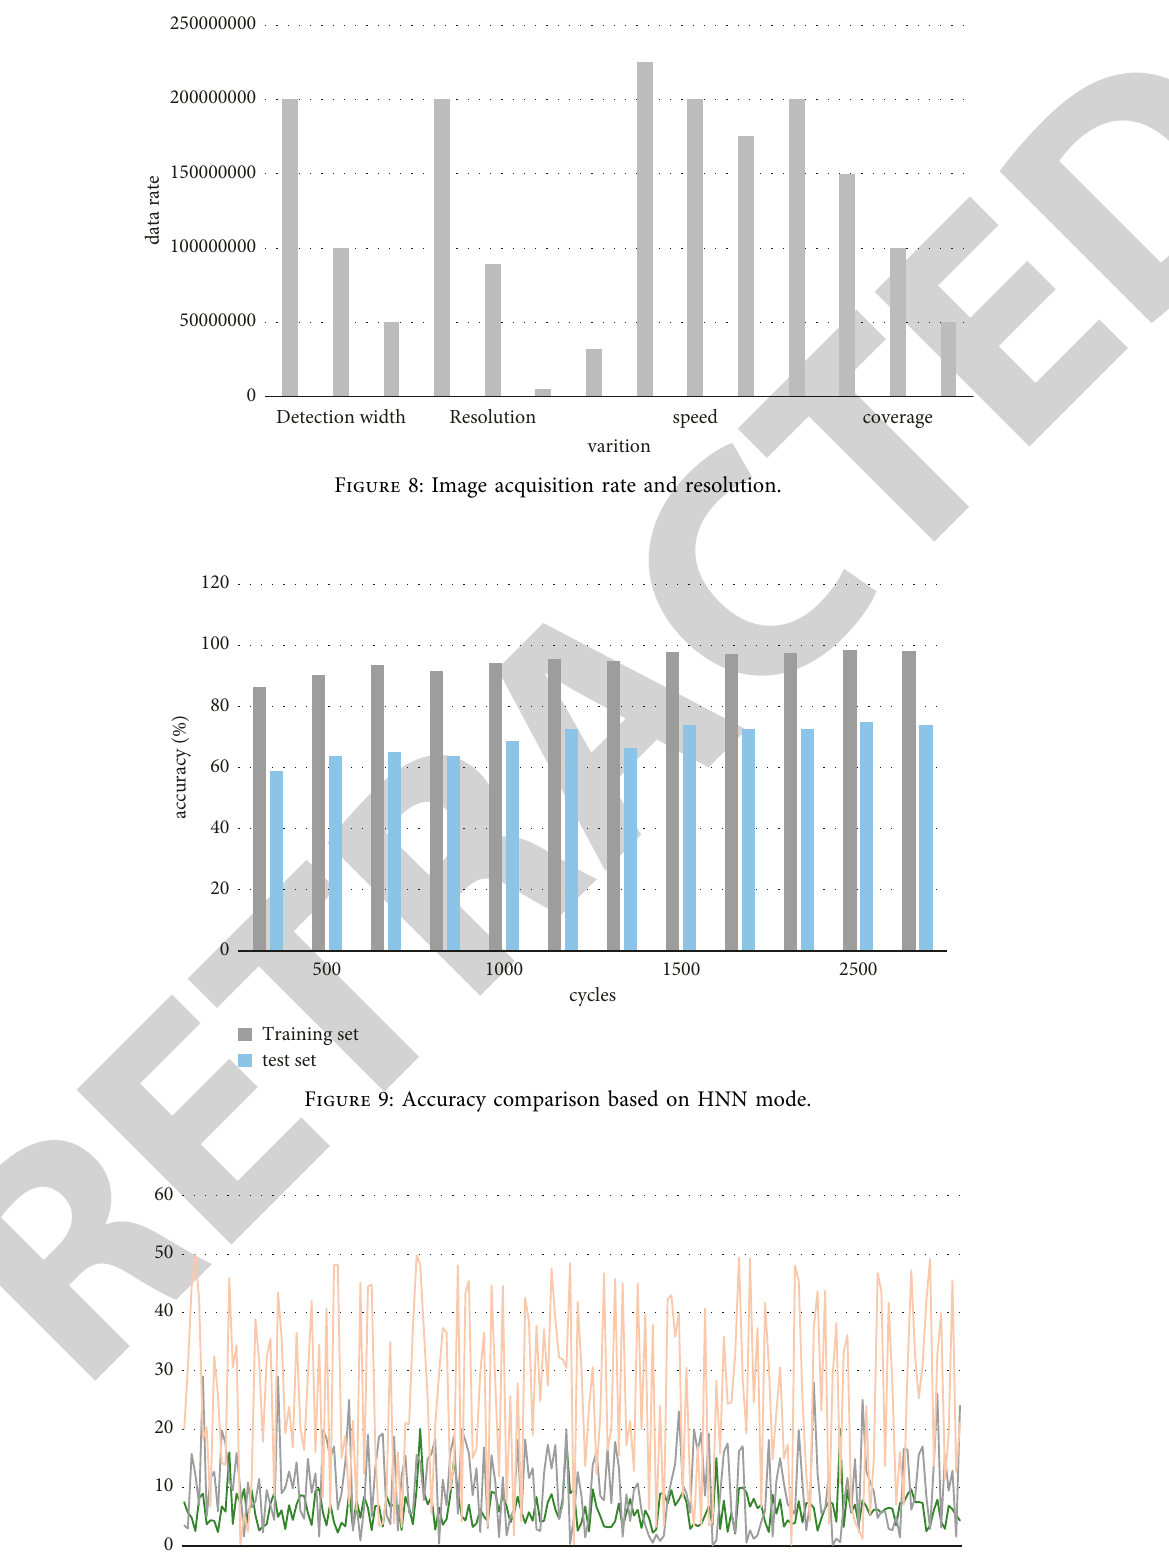
Figure 9: Accuracy comparison based on HNN mode.